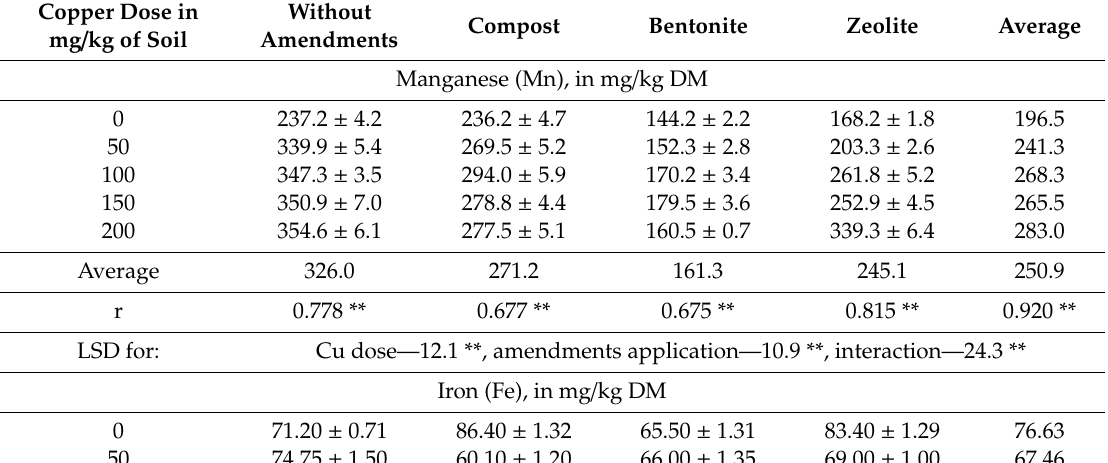
Table 4. E ff ect of copper contamination and amendments on concentration of manganese (Mn), iron (Fe) and cobalt (Co) on shoots of maize ( Zea mays